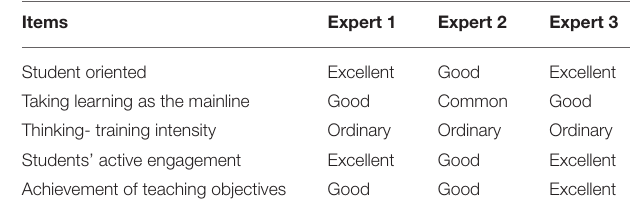
TABLE 6 | Assessment of the experts of the classroom